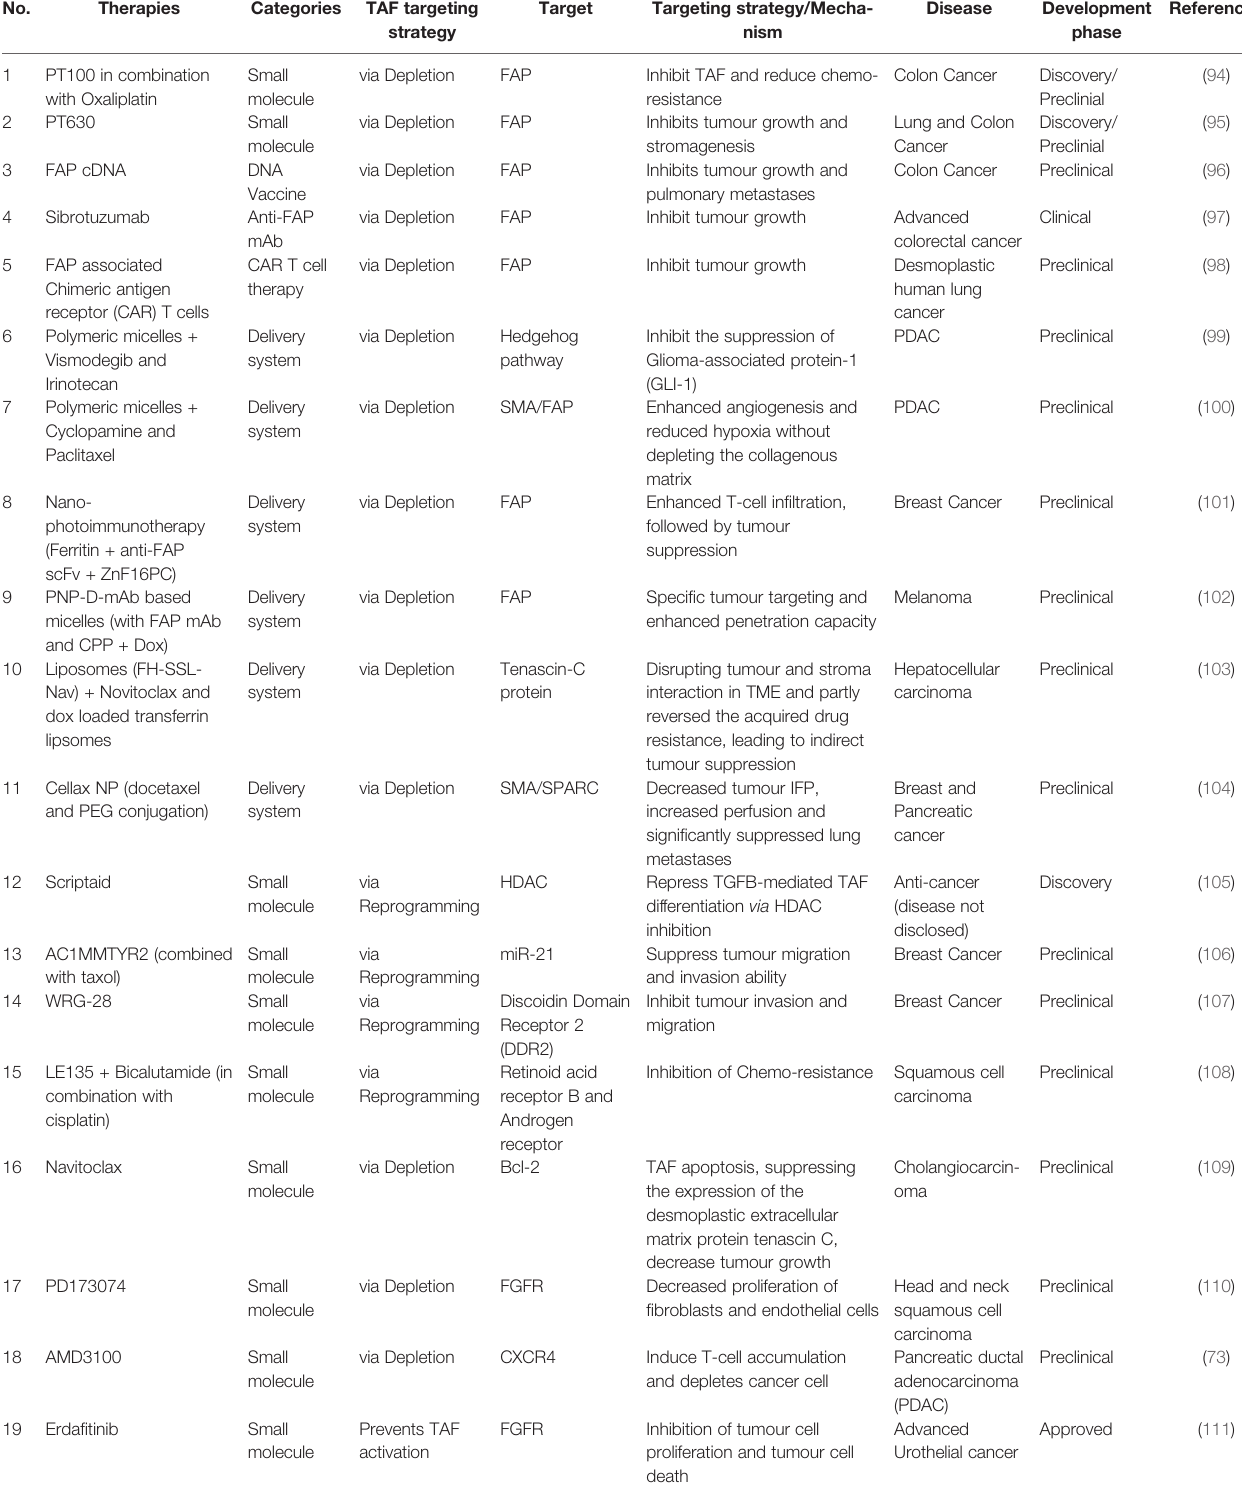
TABLE 1 | A representative panel of pharmacological interventions targeting tumour-associated fi